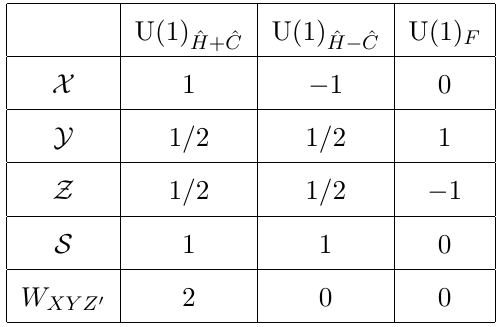
Table 1 . Gauge and global symmetry charges for N = 4 SQED with one flavor.